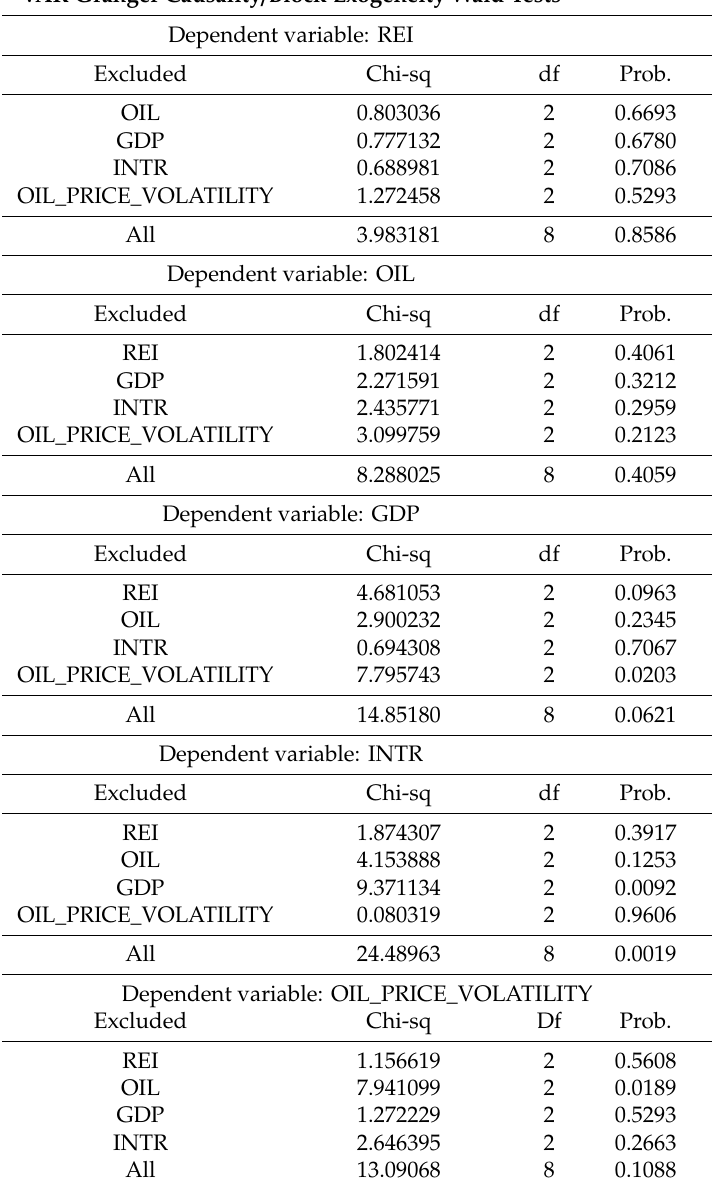
Table 2. Granger Causality